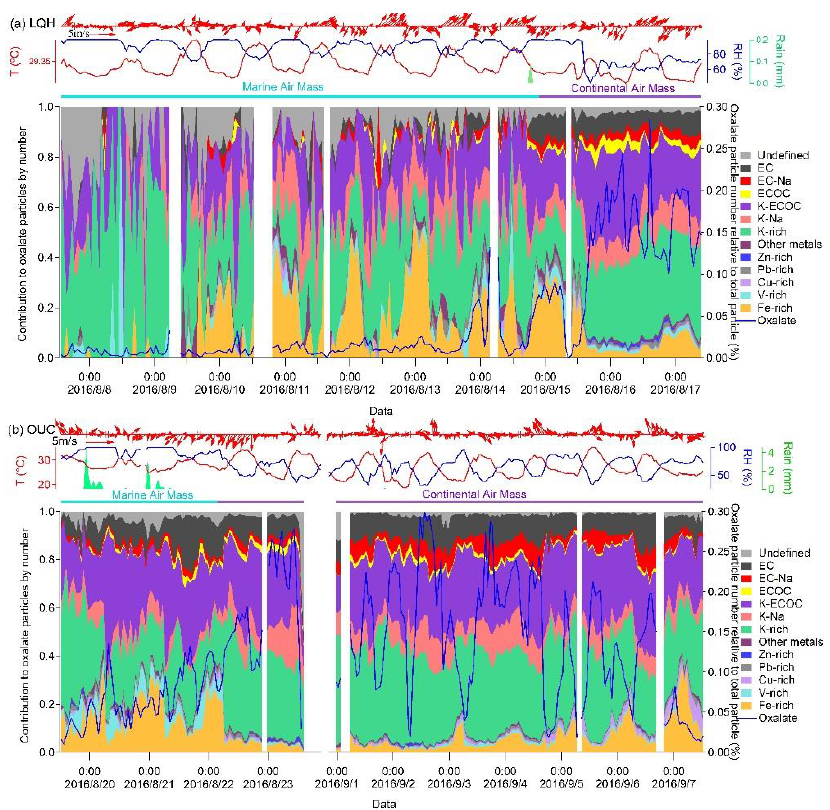
Figure 1. Size-resolved contributions of classified oxalate-containing particle groups to the total oxalate particles (by number percentage) at ( a ) LiuqingHe Scenic Spot [LQH] and ( b ) Ocean Uni- versity of China [OUC].